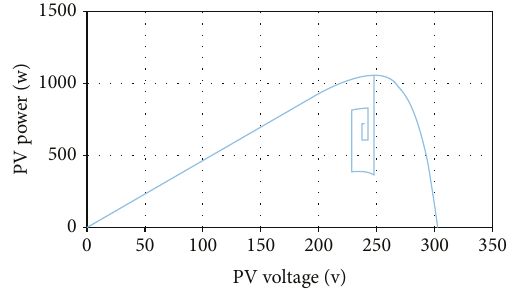
Figure 4: P-V curve with P&O.